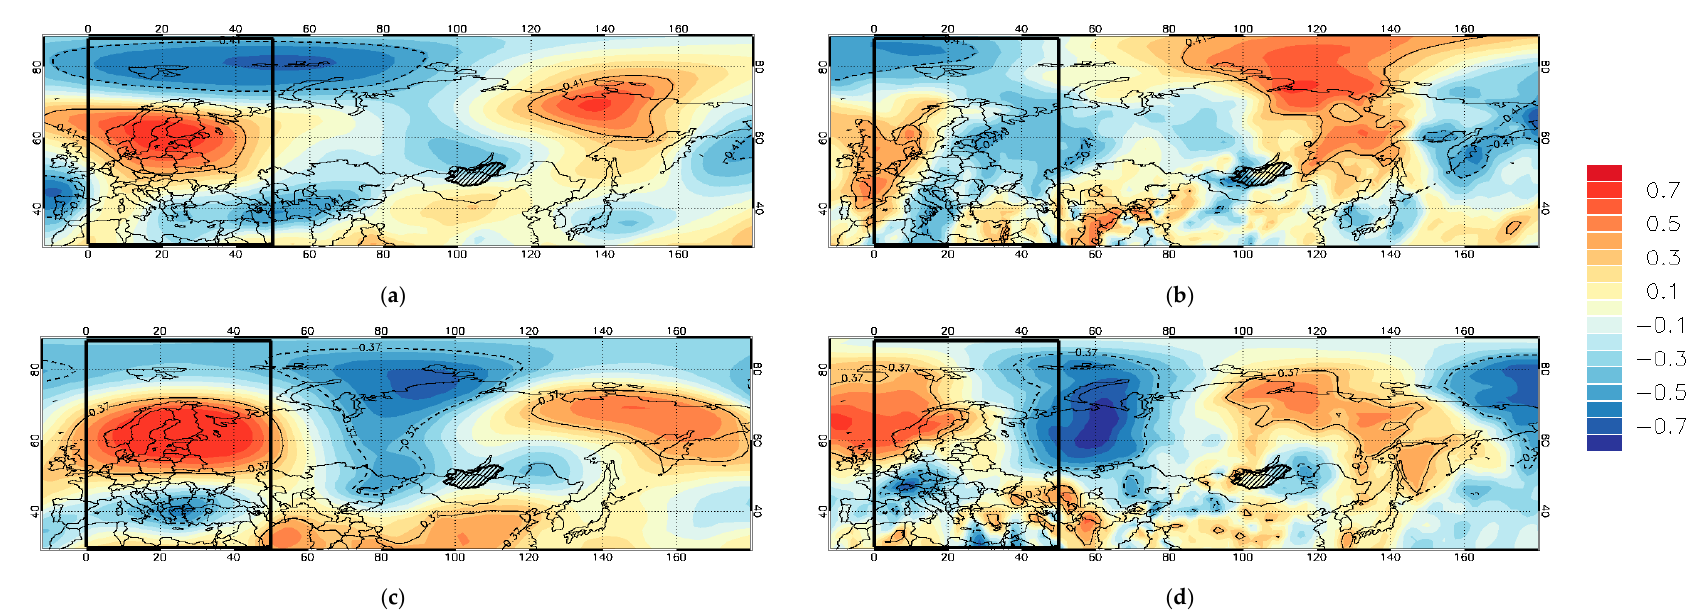
Figure 12. Correlation coefficients of E -BF, and Z500 ( a , c ) and E -BF, and v-component of wind at 850 hPa (V850) ( b , d ) for 1979–1995 ( a , b ) and 1996–2016 ( c , d ). The description is the same as in Figure 8.